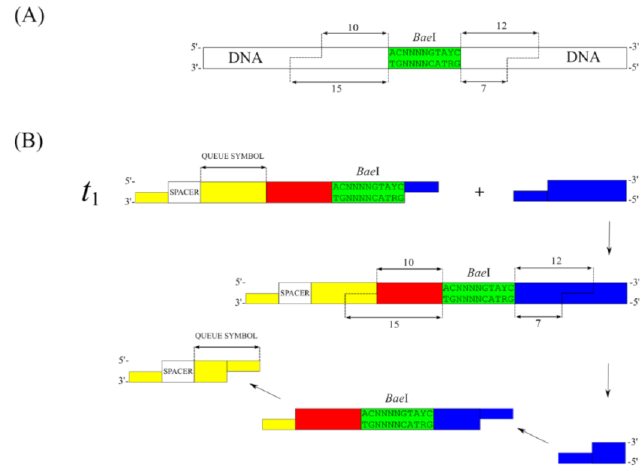
Figure 6. ( A ) The operation of the restriction enzyme Bae I. ( B ) The mechanism of writing the queue symbols using the restriction enzyme Bae I. Abbreviations: t 1 —the transition molecule named t 1